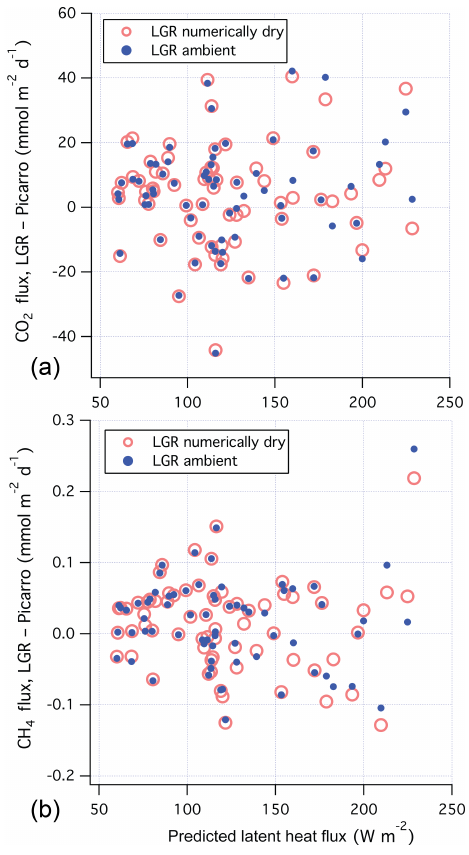
Figure 5. Differences in CO 2 (top), and CH 4 (bottom) fluxes be- tween LGR (numerically dry as well as ambient) and Picarro (phys- ically dry) vs. the bulk latent heat flux for the air–water wind sector of 45 to 80 ◦ . The numerical H 2 O correction has the largest effect on the trace gas fluxes under conditions of high latent heat flux.